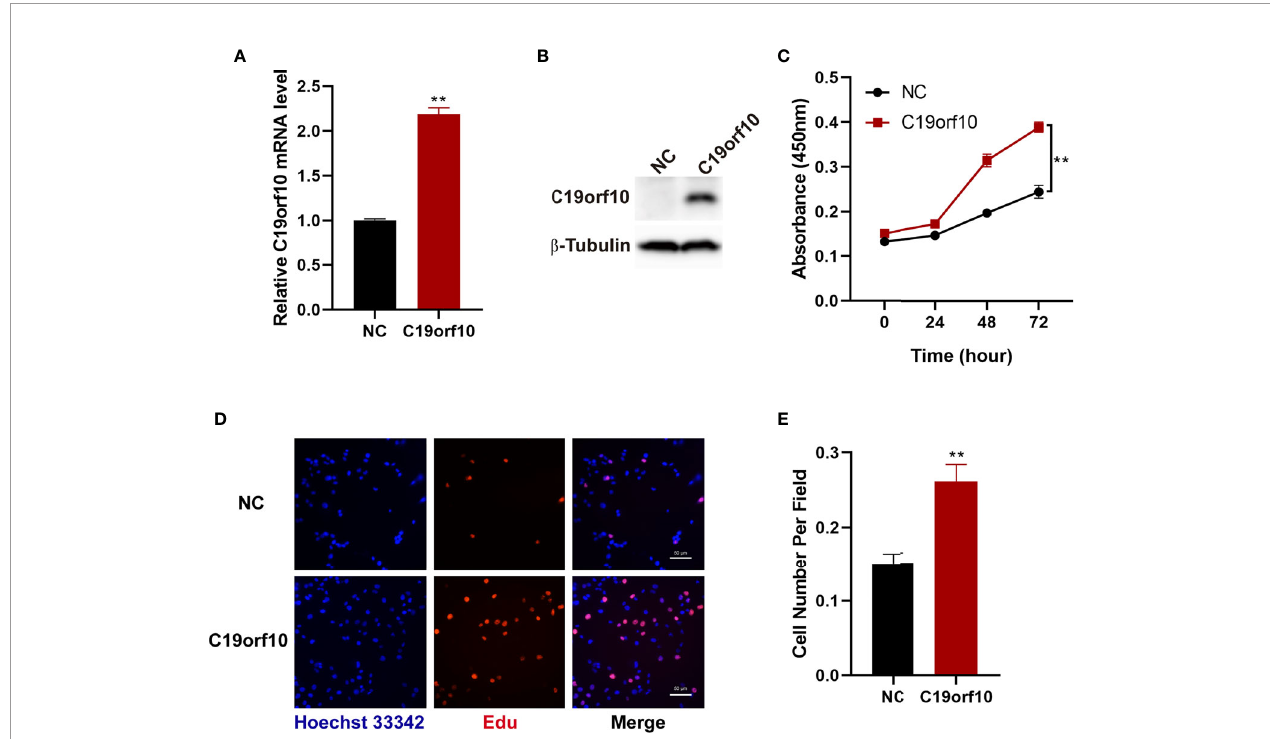
FIGURE 4 | Overexpression of C19orf10 enhances the viability and proliferation of KIRC cells. (A, B) The verify of C19orf10 overexpression on mRNA (A) and protein level (B) , n=3. (C) C19orf10 promoted the viability of 769-P cells, n=3. (D, E) C19orf10 increased the proliferation of 769-P cell, n=8. Scale bar, 50 m m, Mean ± SD is shown, ** P < 0.01 by two-way ANOVA (C) , Student ’ s t-test (A, E)